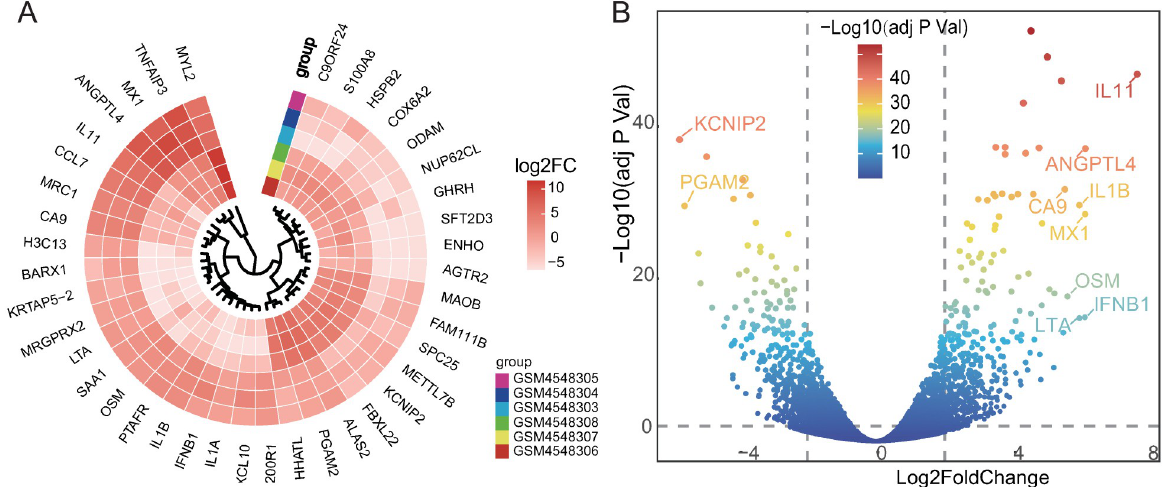
Fig 2. Identification of differentially expressed genes in the GSE150392 dataset by differential analysis. (A) The circular heatmap exhibited the top 40 DEGs sorted by the Log2 FC for the GSE150392 dataset. (B) DEGs in the gradient volcano plot. The top 10 genes were labeled on the plot which was sorted by the Log2 FC and most of them were upregulated (except KCNIP2 and PGAM2 which were downregulated). Two vertical lines indicated |Log2 FoldChange| � 2, severally, and the horizontal line indicated the adj P Val of 0.01. The color of the plots represents the Log2 FoldChange levels [37]. DEGs, differentially expressed genes; FC, fold change; adj P Val, adjusted P-Value.